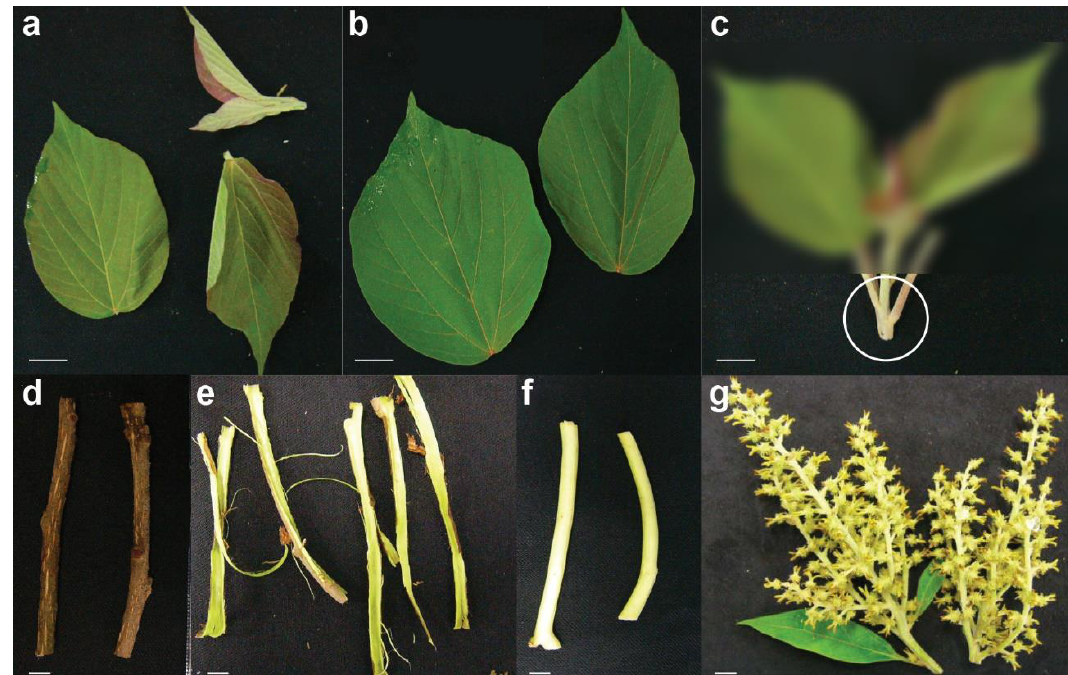
Figure 1. Tissues of Mallotus japonicus used in this study for the multi-omics analysis: ( a ) young leaf, ( b ) mature leaf, ( c ) young stem, ( d ) mature stem, ( e ) bark, ( f ) central cylinder, and ( g ) inflorescence. The scale bar represents 1 cm.